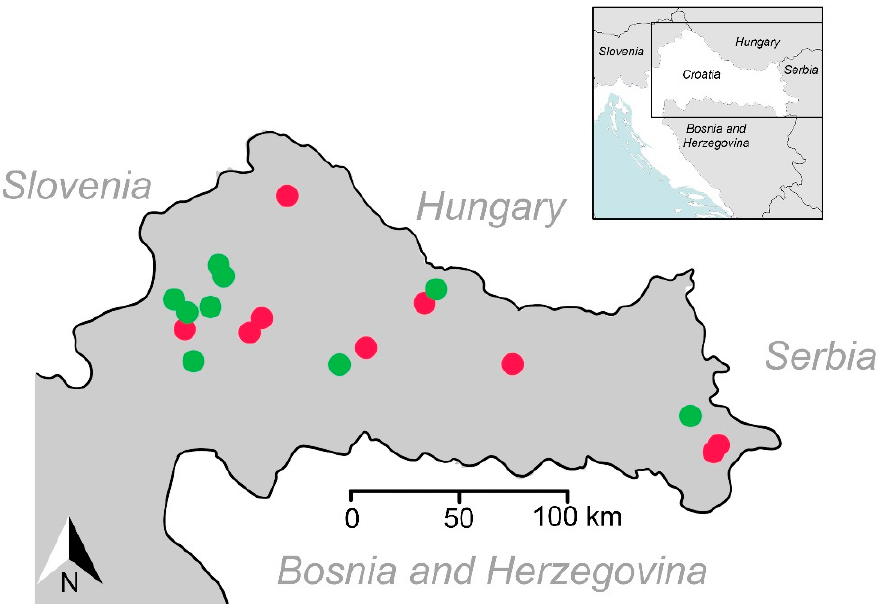
Figure 1. Sampling sites of Cydia pomonella in Croatian orchards: red, integrated orchard; green, organic orchard. Table 1. Number of CM individuals used for geometric morphometric and SNPs analyses: n, sample size.